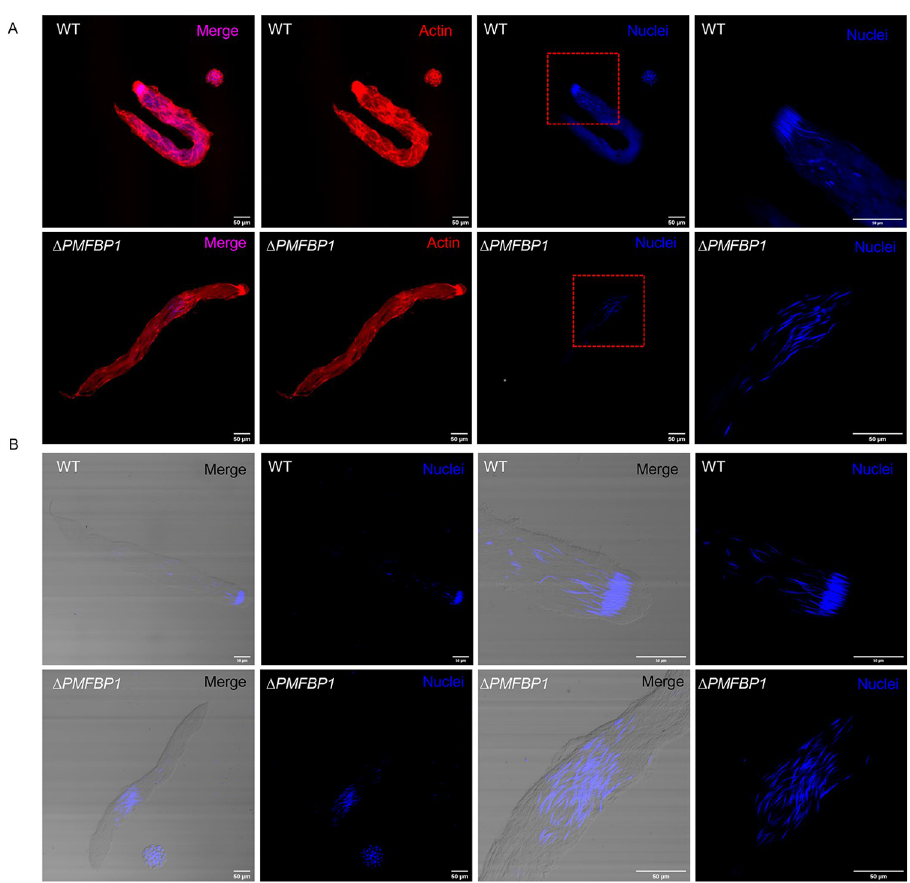
Fig 4. BmPMFBP1 mutation impairs the development of eupyrene sperm bundles. The eupyrene sperm bundles showed abnormal location and spacing of nuclei in Δ BmPMFBP1 males. (A) Fluorescence image of eupyrene sperm bundles in testes of wildtype (WT) males and Δ BmPMFBP1 males on the seventh day of pupal stage. The filamentous actin proteins were stained with TRITC Phalloidin, the nuclei were stained with Hoechst 33258. (B) Additional image of eupyrene bundles with fluorescence staining for